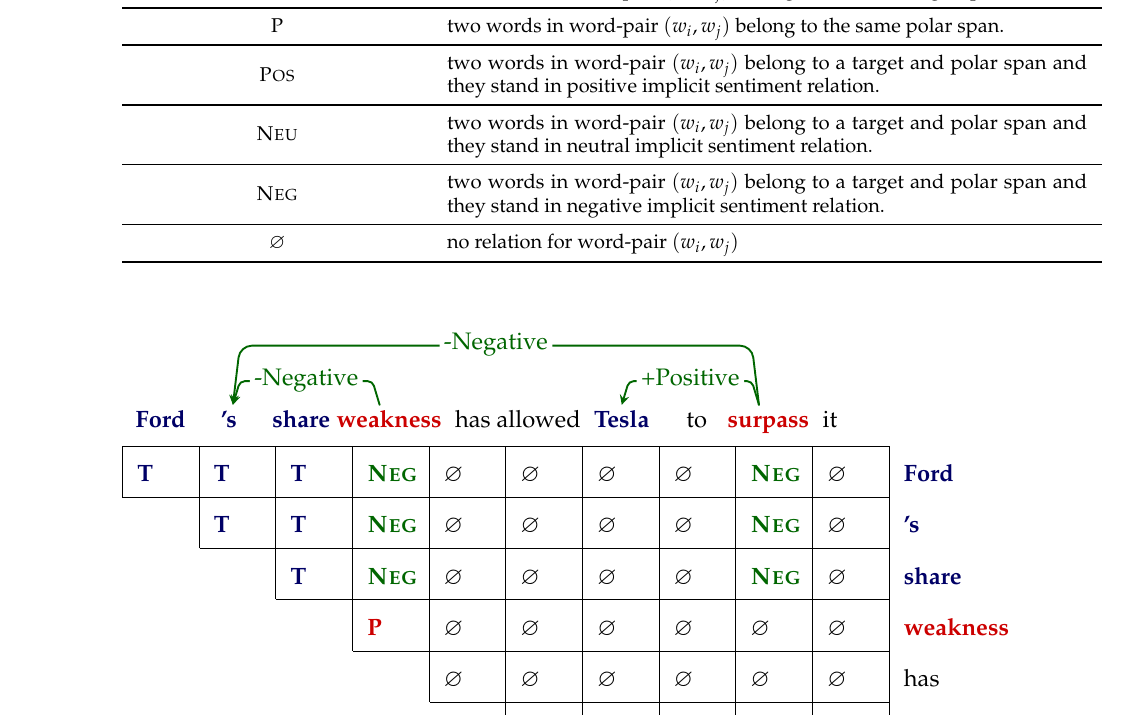
Table 5. The meaning of tags in the implicit sentiment-polarity triplet task. Tag Meaning T two words in word-pair ( w i , w j ) belong to the same target span. P two words in word-pair ( w i , w j ) belong to the same polar span. P OS